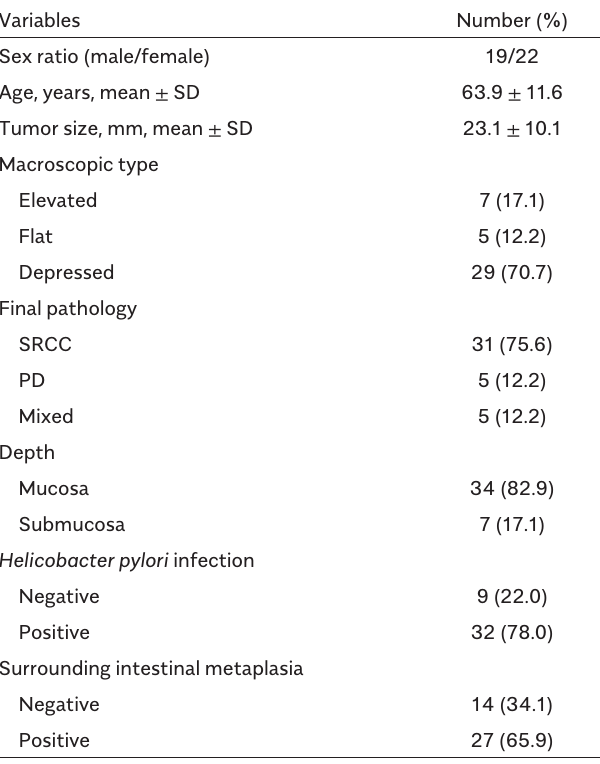
Table 1. Clinical Characteristics, Endoscopic, and Pathological Findings